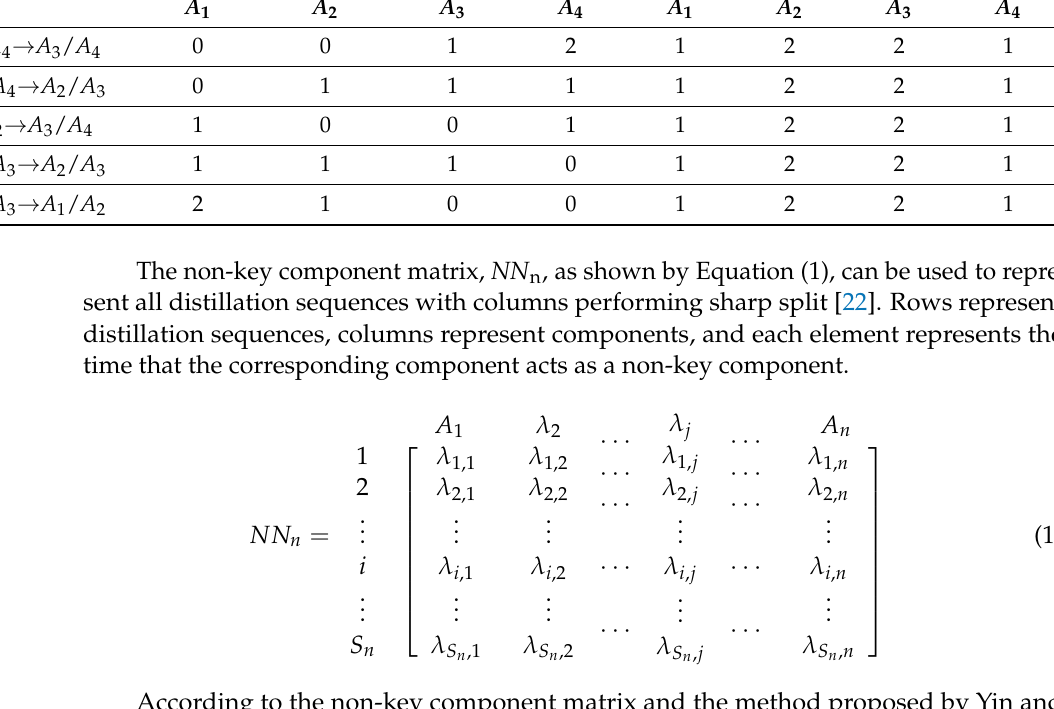
Table 1. Five distillation sequences separating four-component mixture. Number of Times as Non-Key Components Number of Times as Key Distillation Sequences